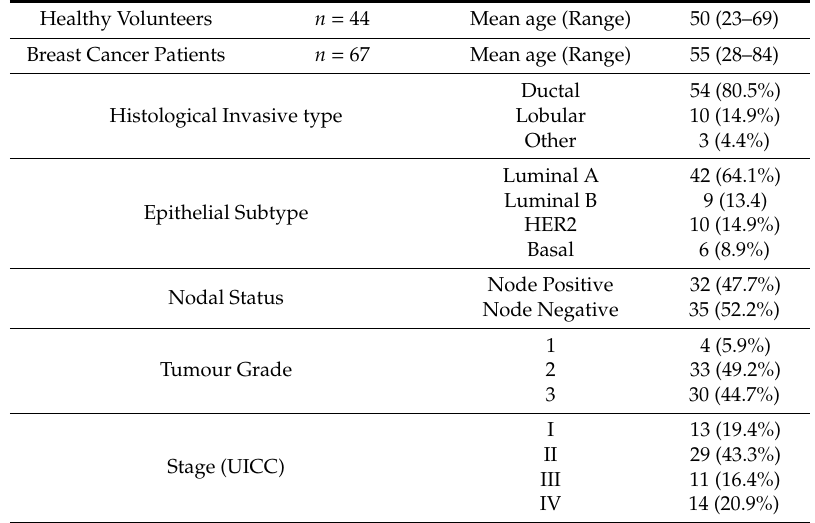
Table 1. Clinicopathological characteristics of breast cancer patients from whom serum EVs were